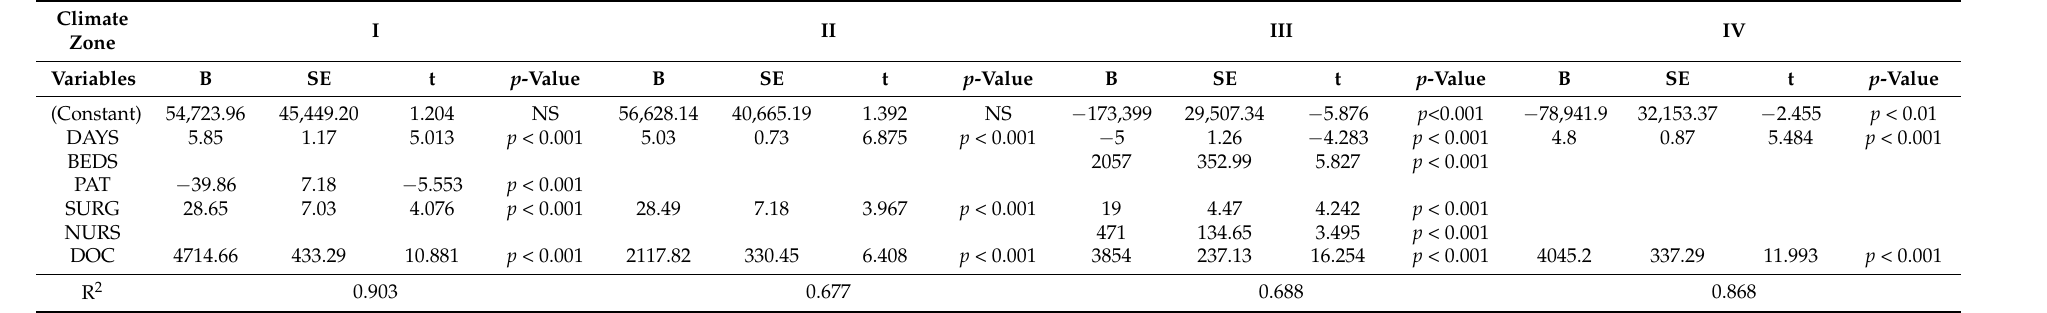
Table 5. Backward stepwise regression analysis with EEC as dependent variable according to the climate zones in Poland.